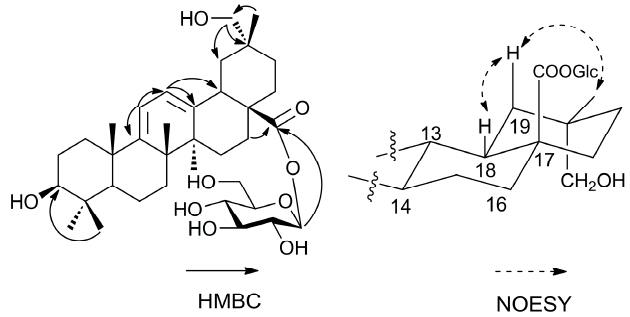
Figure 3. Key HMBC (From H to C) and NOESY (From H to H) correlations for 6.